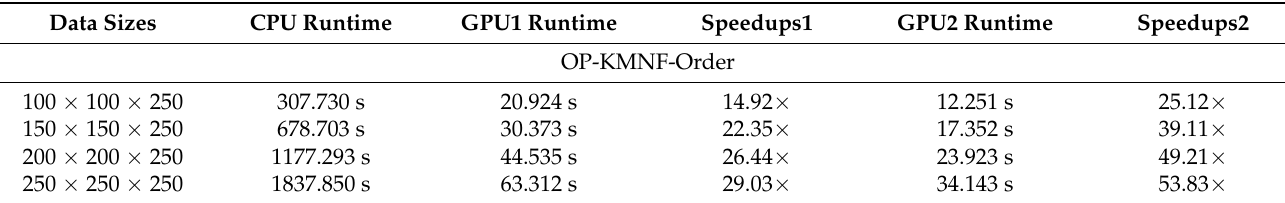
Table 9. The runtimes and speedups of OP-KMNF on two different computing